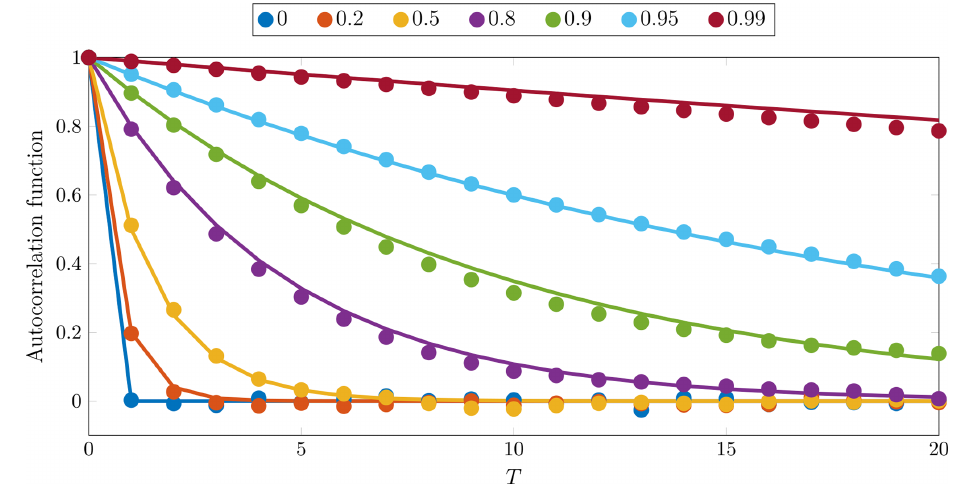
Figure 4. Estimated autocorrelation functions (dotted lines) for different values of the temporal correlation factor φ as a function of the temporal lag T . Solid lines represent the theoretical autocorrelation functions given by Eq. (17).